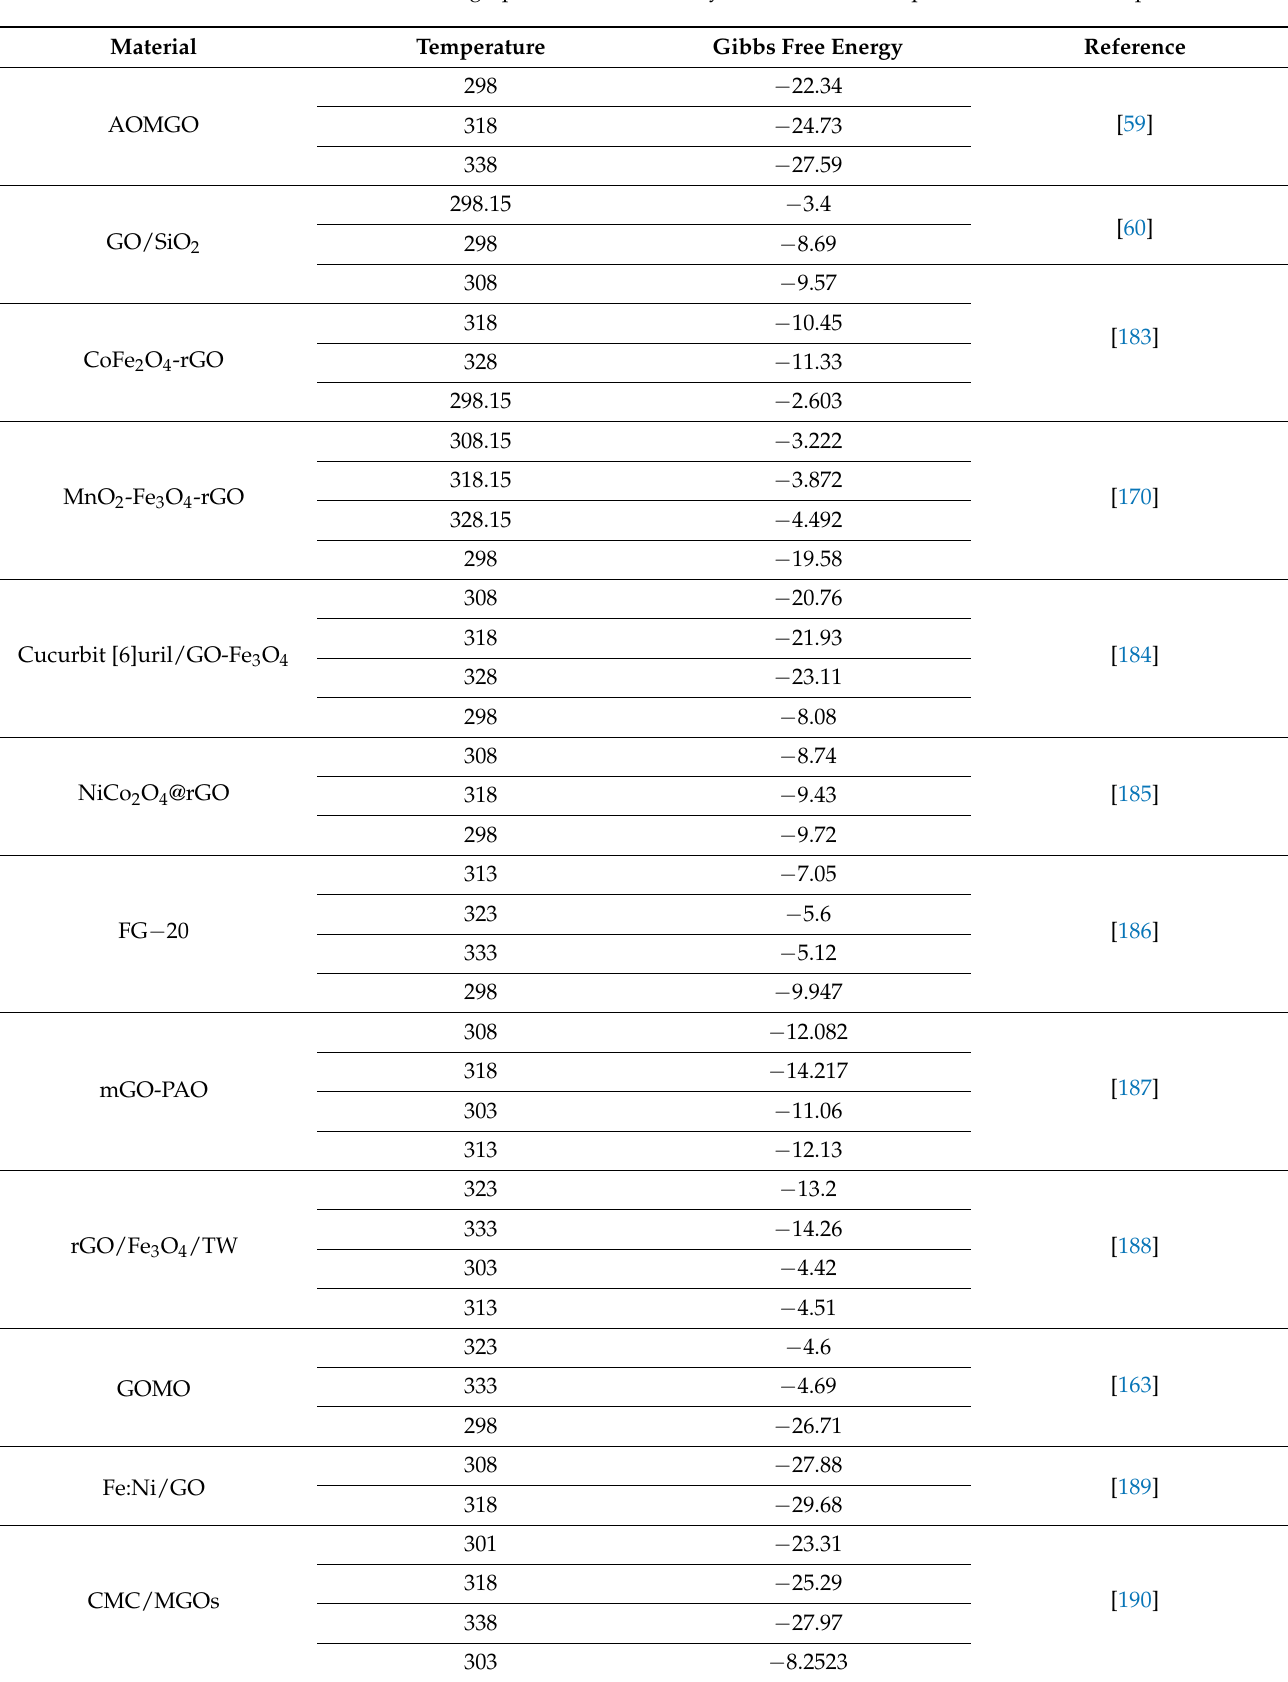
Table 5. List of graphene oxide–metal hybrids used in adsorption of uranium